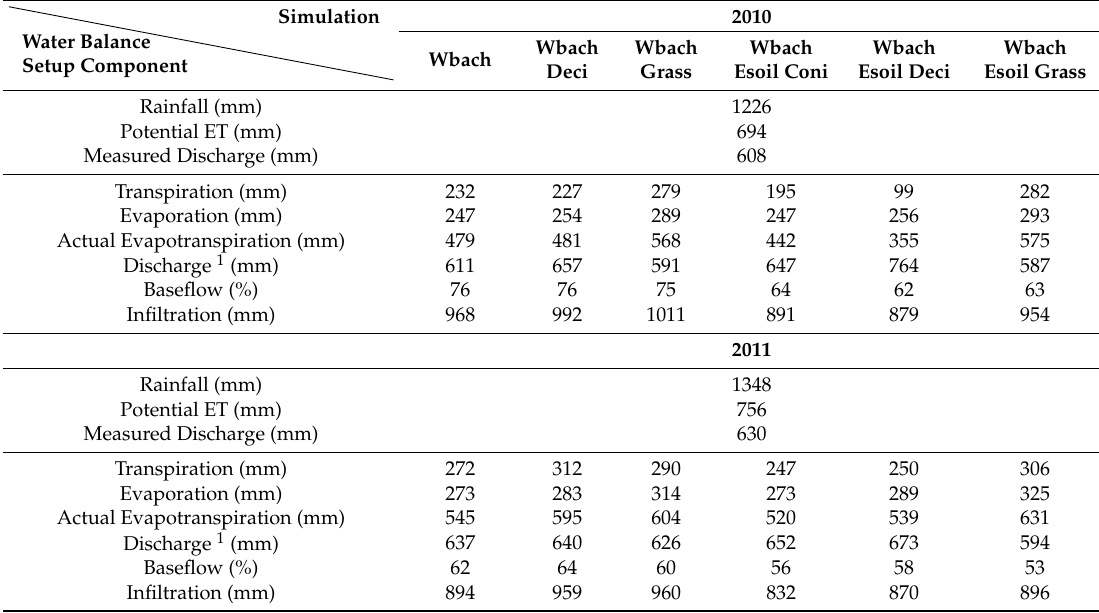
Table 4. Water balance components for Wüstebach